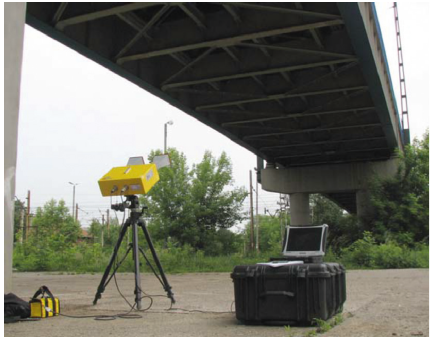
Figure 9: IBIS-S radar unit under the tested bridge